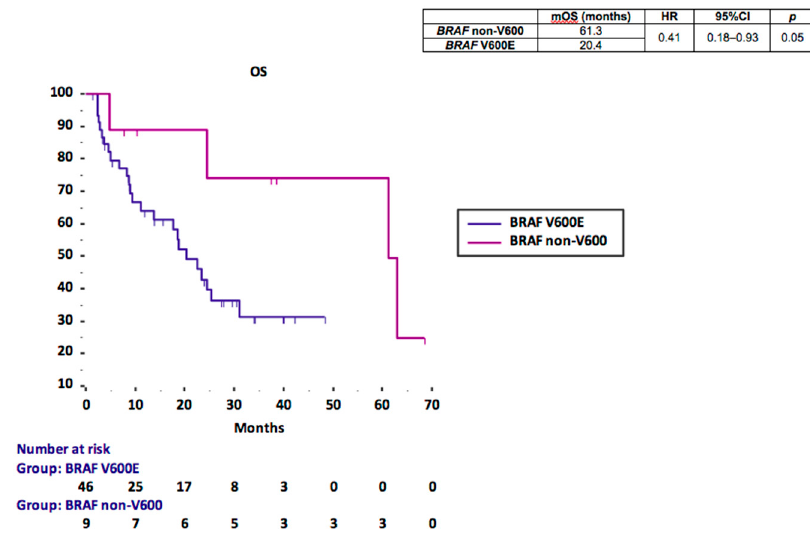
Figure 1. Kaplan–Meier OS curves according to BRAF mutational status.